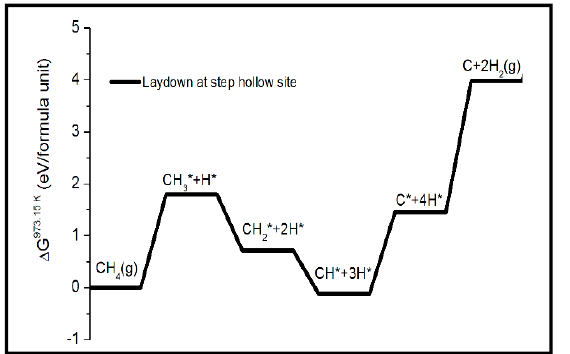
Figure 1. Thermodynamic reaction profile of the methane decomposition reaction on the Ni(322) surface for the laydown of monomeric carbon at the step hollow site of the surface.